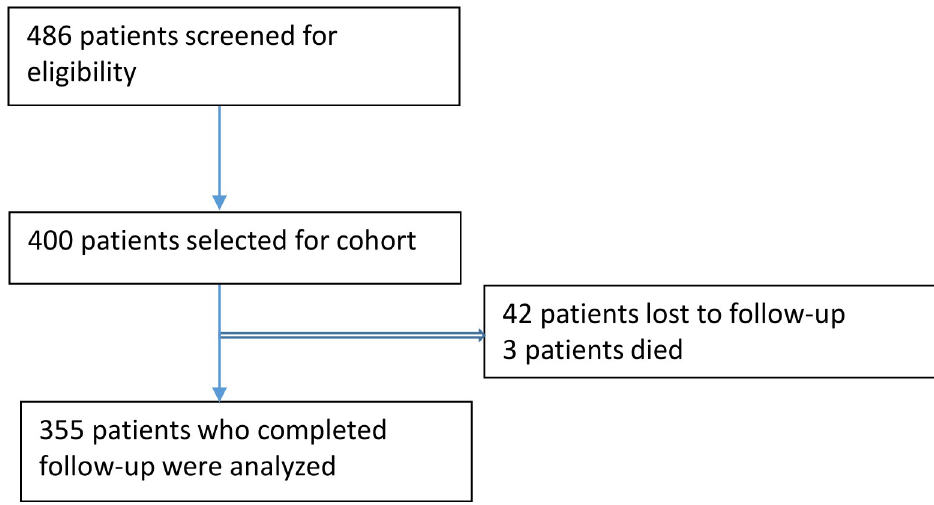
Fig 1. Patient selection for this prospective cohort